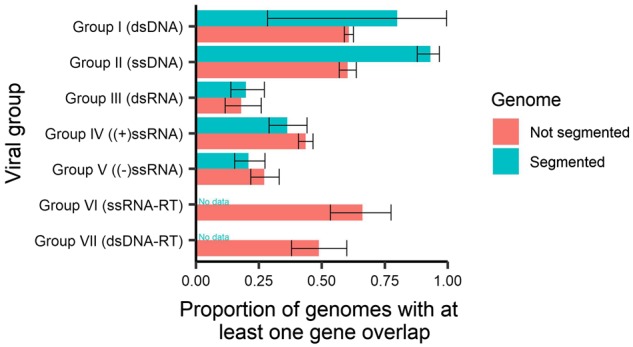
Proportion of genes with at least one instance of gene overlap stratified by segmented genomes. Error bars represent 95 per cent CIs.